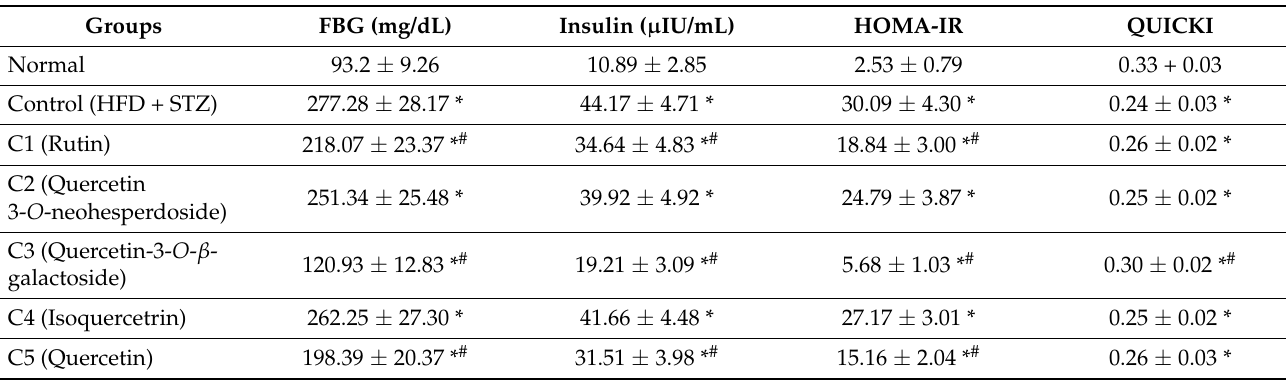
Table 2. The effect of the isolated compounds on fasting blood glucose, insulin, and insulin resistance indices in the experimental rats.